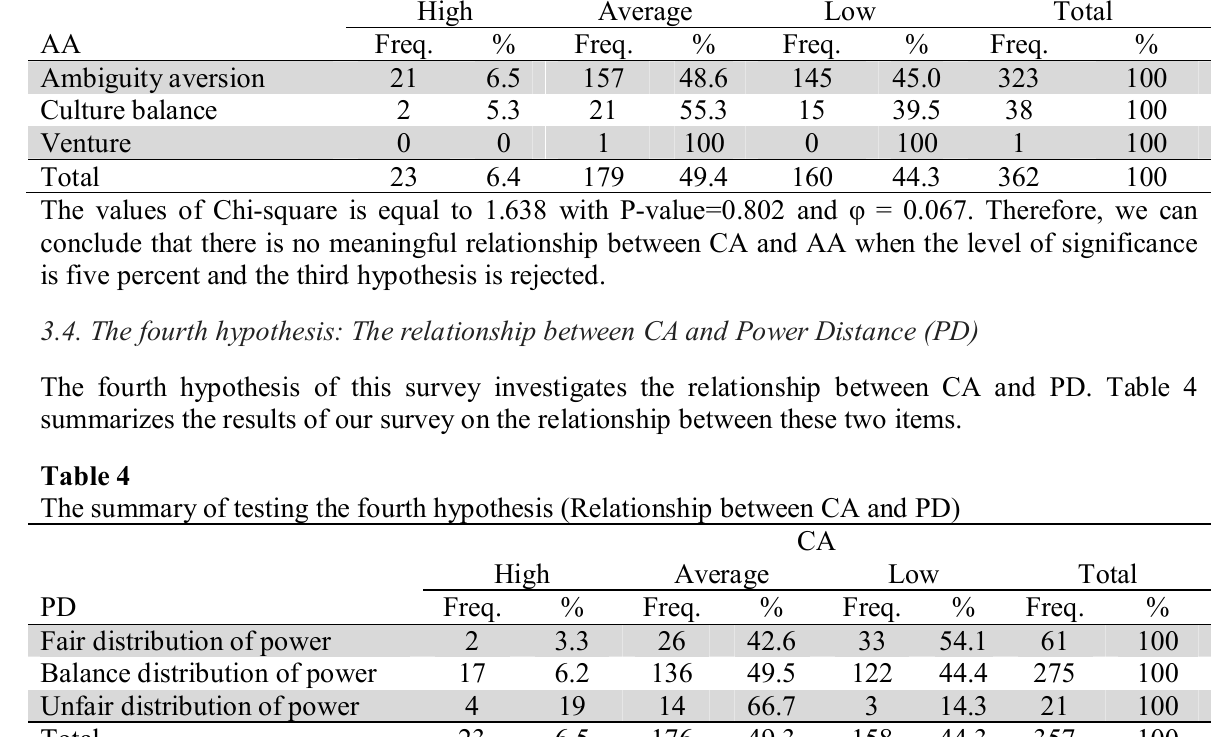
High Average Low Freq.